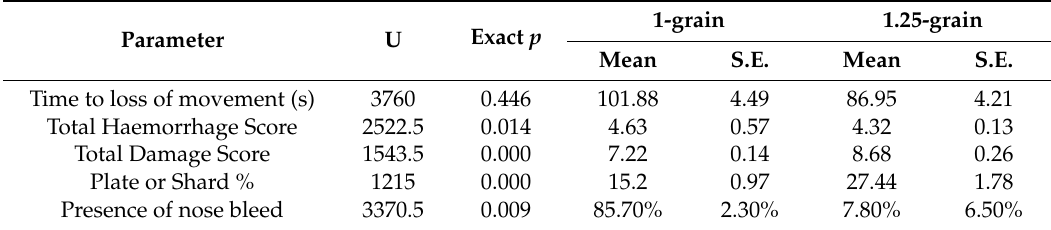
Table 2. Results of the tests for differences in the remaining outcome variables between the two cartridge sizes, showing the U statistic, significance and mean (standard error, S.E.) within each group.